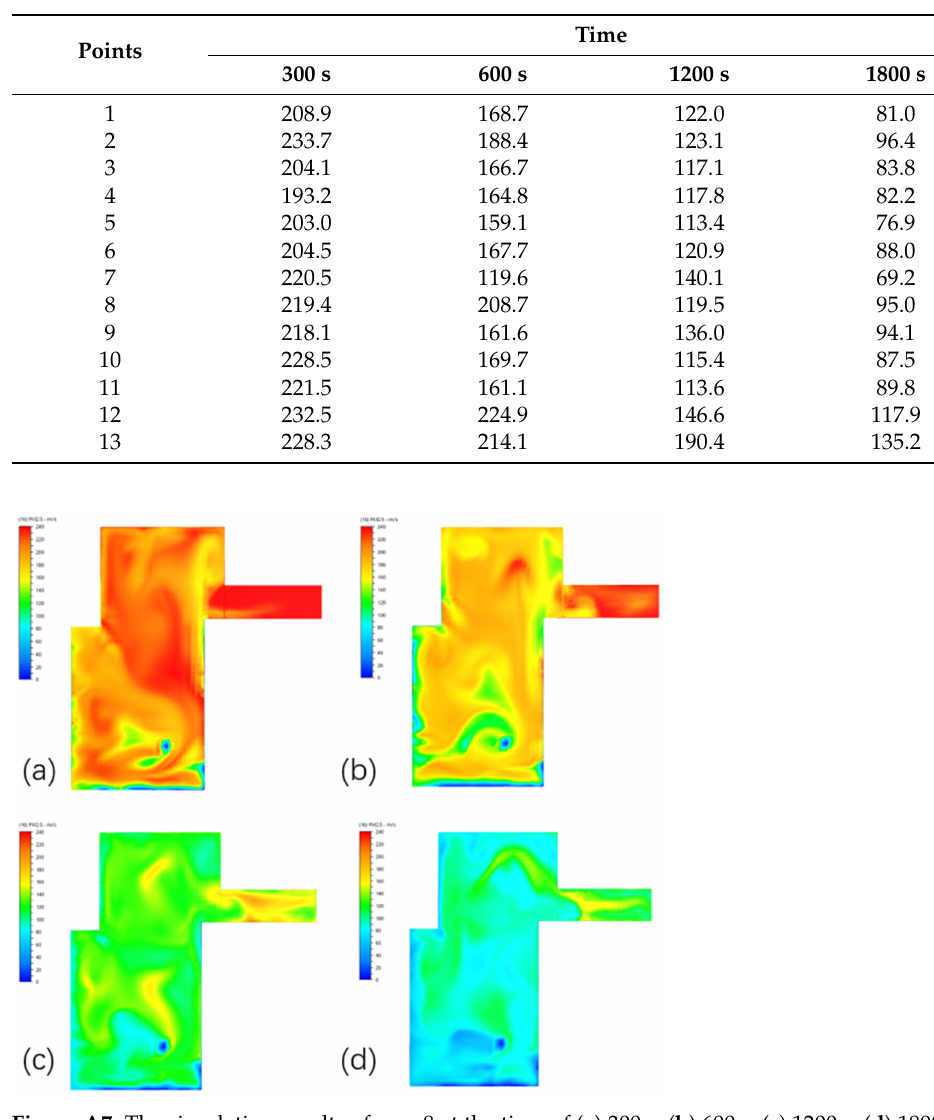
Table A6. Quantitative results of case 7.